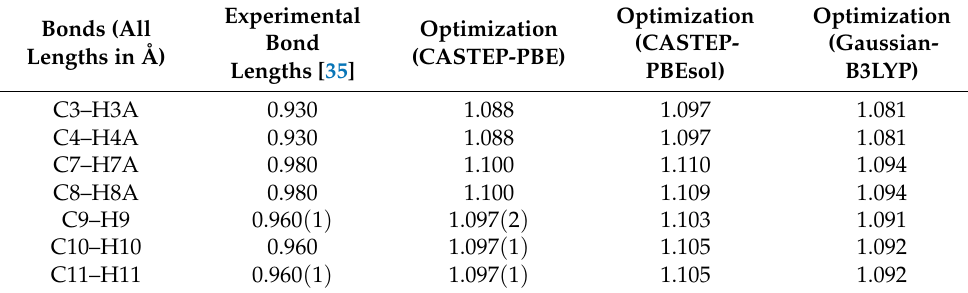
Table 2. Optimized bond lengths C-H of the C 10 H 13 BO 3 S compound.